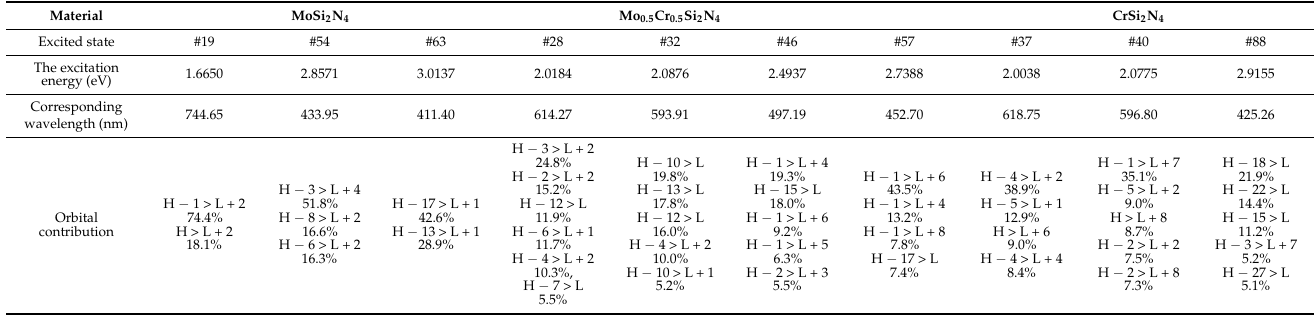
Figure 4. The oscillator strength of MoSi 2 N 4 , Mo 0.5 Cr 0.5 Si 2 N 4 and CrSi 2 N 4 . Table 1. The excited state, the excitation energy, corresponding light wavelength and orbital con- tribution of 2D MoSi 2 N 4 , Mo 0.5 Cr 0.5 Si 2 N 4 and CrSi 2 N 4. L: LUMO (Lowest Unoccupied Molecular Orbital); H: HOMO (Highest Occupied Molecular